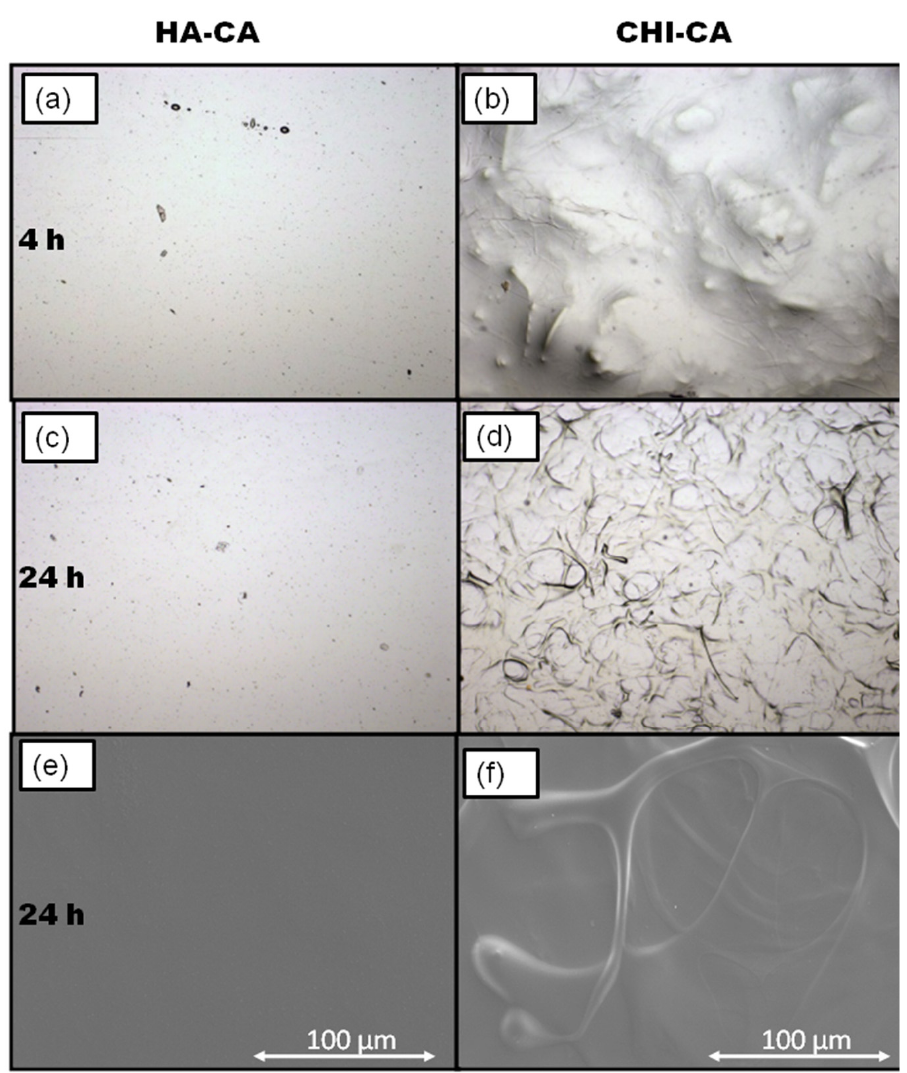
Figure 11. ( a ) HA-CA photographs taken with microscope after 4 h with ( × 4 lens and 1.62 µ m/pixel) and ( b ) CHI-CA photographs taken with microscope after 4 h with ( × 4 lens and 1.62 µ m/pixel) ( c ) HA-CA photographs taken with microscope after 24 h ( × 4 lens and 1.62 µ m/pixel) ( d ) CHI-CA photographs taken with microscope after 24 h of drying with × 4 lens (1.62 µ m/pixel) ( e ) HA-CA SEM images after 24 h of drying and ( f ) CHI-CA SEM images after 24 h of drying. After 4 h of drying, noticeable differences between some systems can be